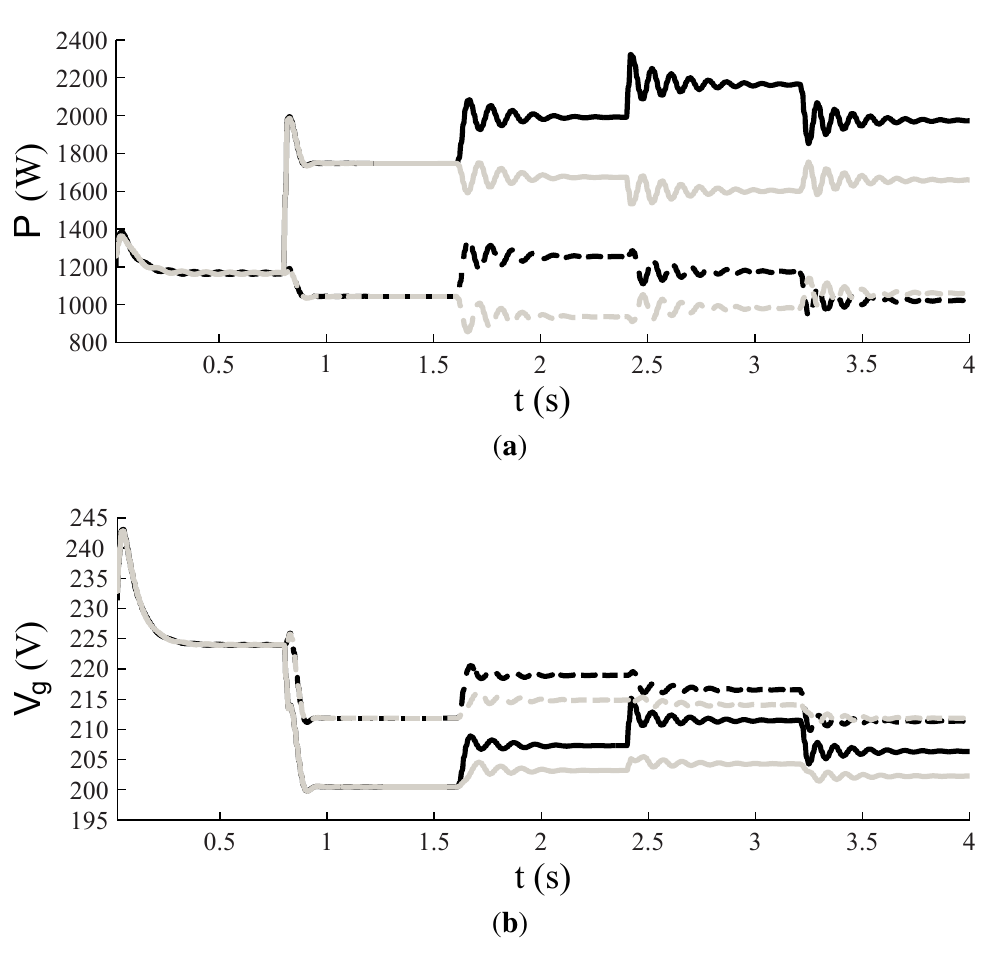
Figure 5. Dynamic simulation: ( a ) Output power P ; ( b ) Terminal voltage V . ( — = DG 1/ phase a; - - - = DG 1/phases b and c; g — (gray)= DG 2/phase a, - - - (gray)= DG 2 /phases b and